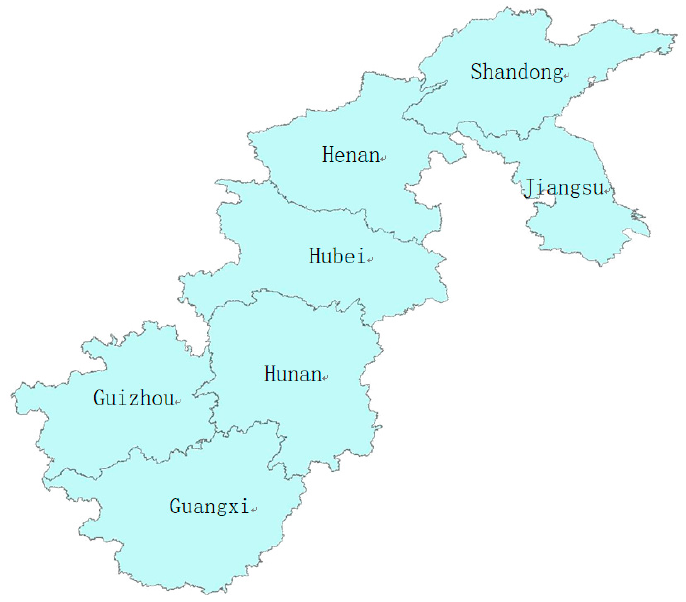
Figure 1. The Administrative Map of Study Areas.